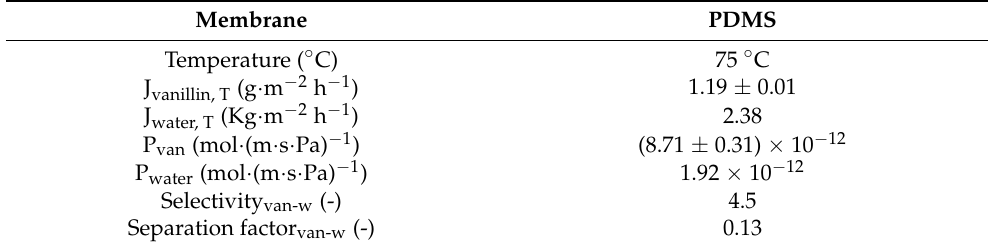
Table 8. Pervaporation operating and performance parameters of the membrane tested (PDMS, Pervap TM4 060) at 75 ◦ C, where J i , T is the total flux of the compound i and P i is the permeability of compound